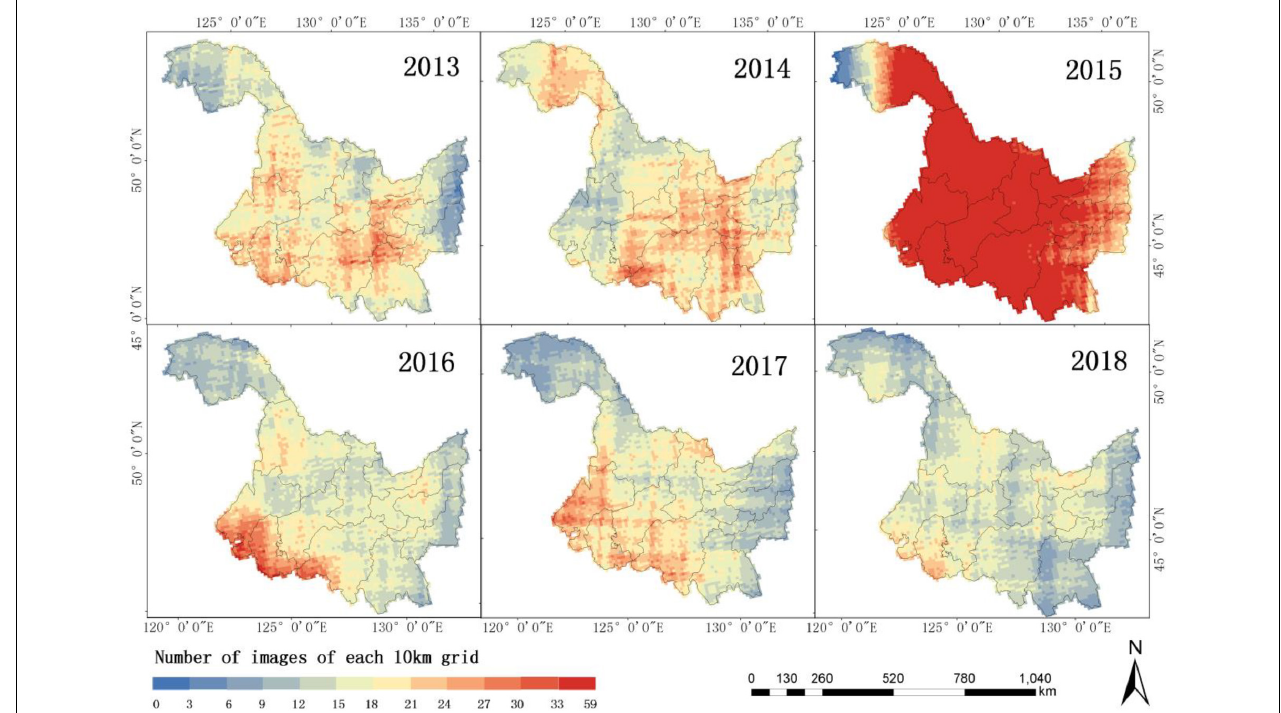
FIGURE 2 | Description of Gaofen 1 (GF-1) data phases used in this study.